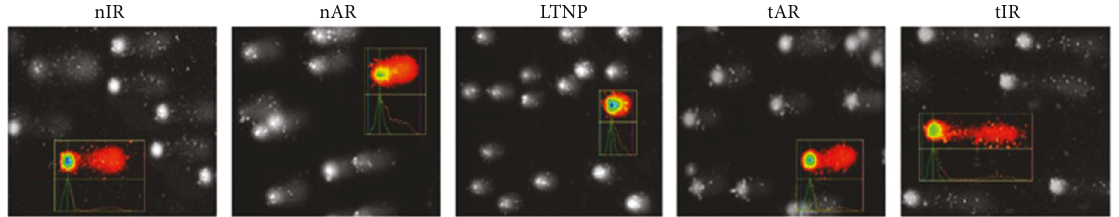
Figure 7: Leukocyte DNA damage representation of fi ve selected nucleoids of patients living with HIV/AIDS, according to the fi ve study groups, whose slides were treated with the formanodipirimidina-DNA glycosylase (FPG) enzyme. By the analysis of the Comet assay, the immuno fl uorescence microscopy shows that LTNP presents less damage than the other